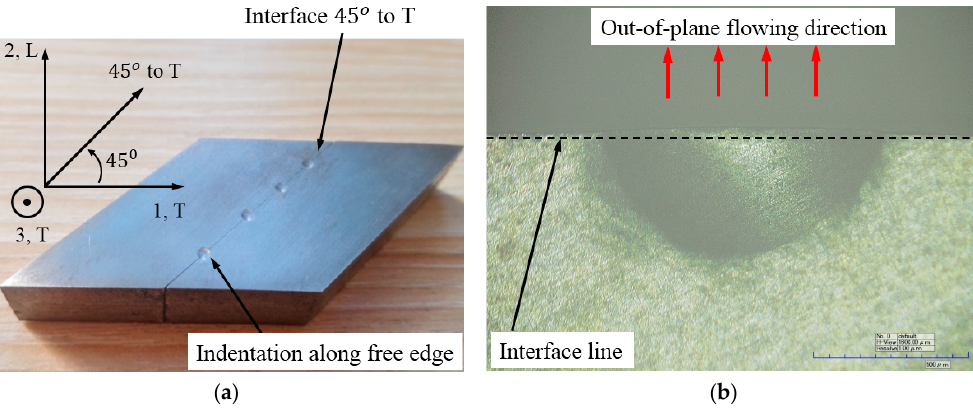
Figure 1. ( a ) Specimen used in cross-sectional indentation experiment; and ( b ) the residual imprint left on the surface of